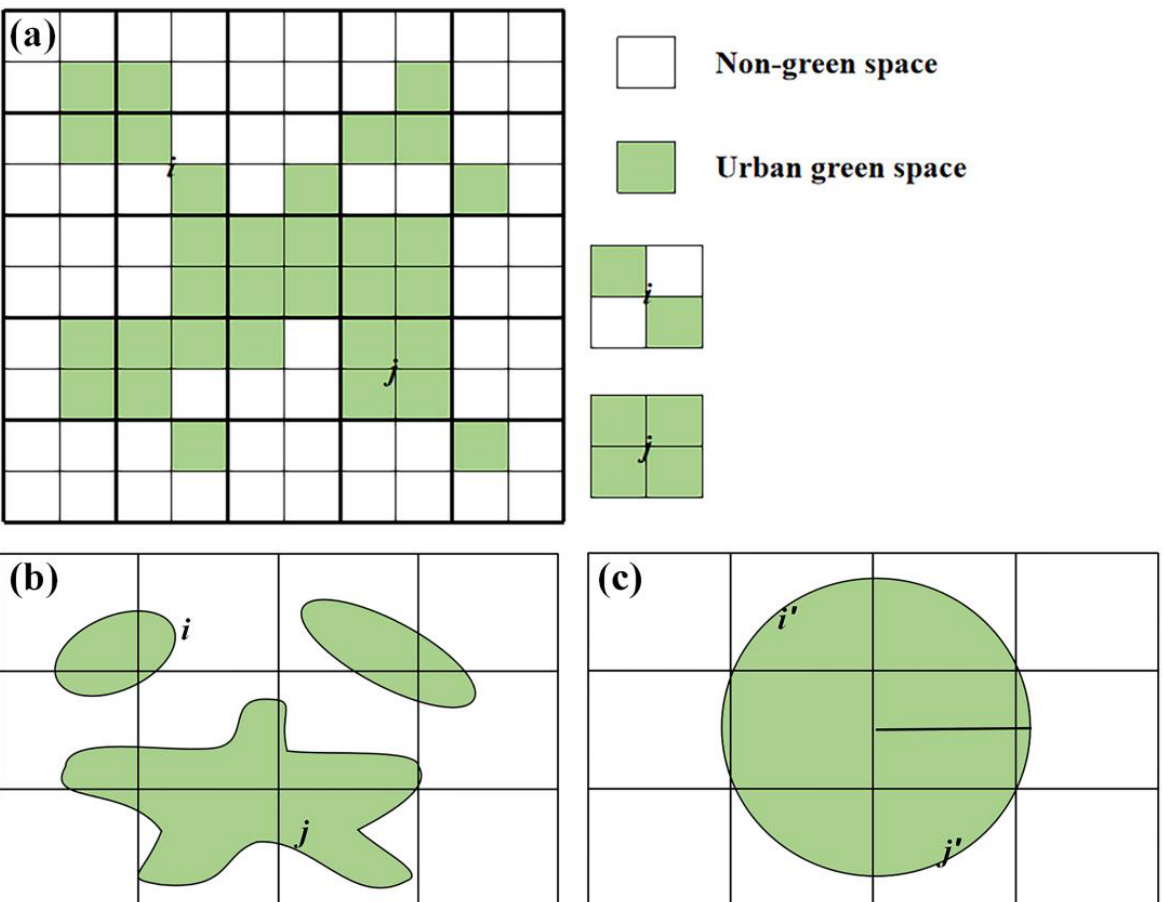
where CI is the 2D GSC index, which is the average power of attraction between the green spaces in grid cells i and j ; Z i is the area of green space in cell i (colored in green in cell i in Figure 1a) and Z j is the area of green space in cell j ( i (cid:54) = j ); d ( i , j ) is the geometric distance between cells i and j ; c is a constant; N is the total number of cells in the grid.